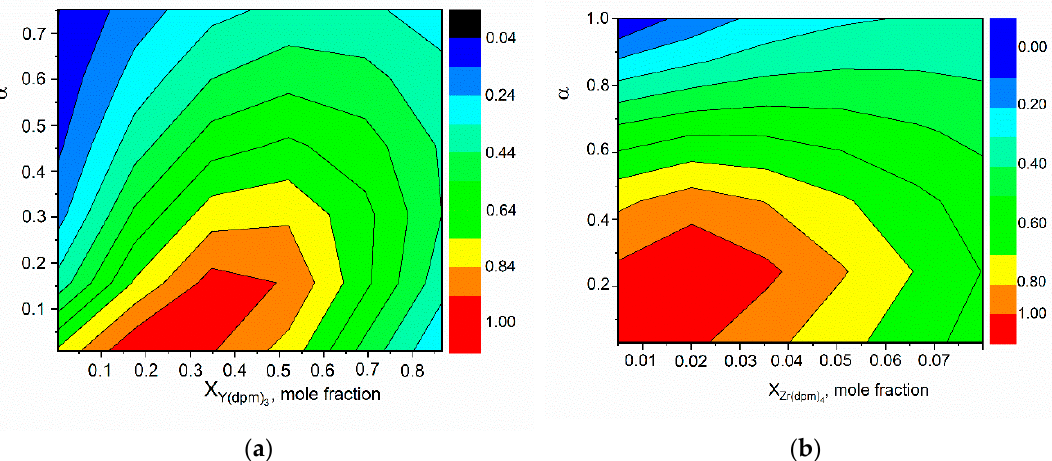
Figure 4. Optimum conditions for coating deposition depending on the mole fraction of precursor and the factor of oxygen excess. ( a )–Y(dpm) 3 vapor deposition, ( b )–Zr(dpm) 4 vapor deposition.